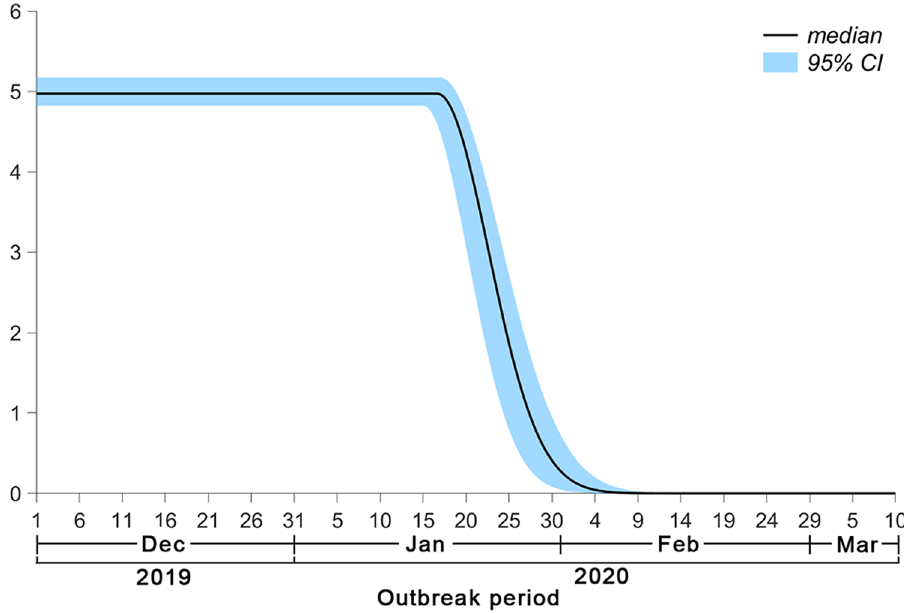
Figure 2. Temporal distribution of the R 0 ( t ). The solid line represents the median value of R 0 ( t ), and the blue area represents the 95% confidence